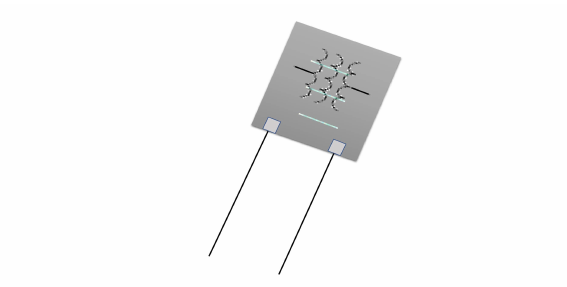
Figure 3. Air moisture monitoring